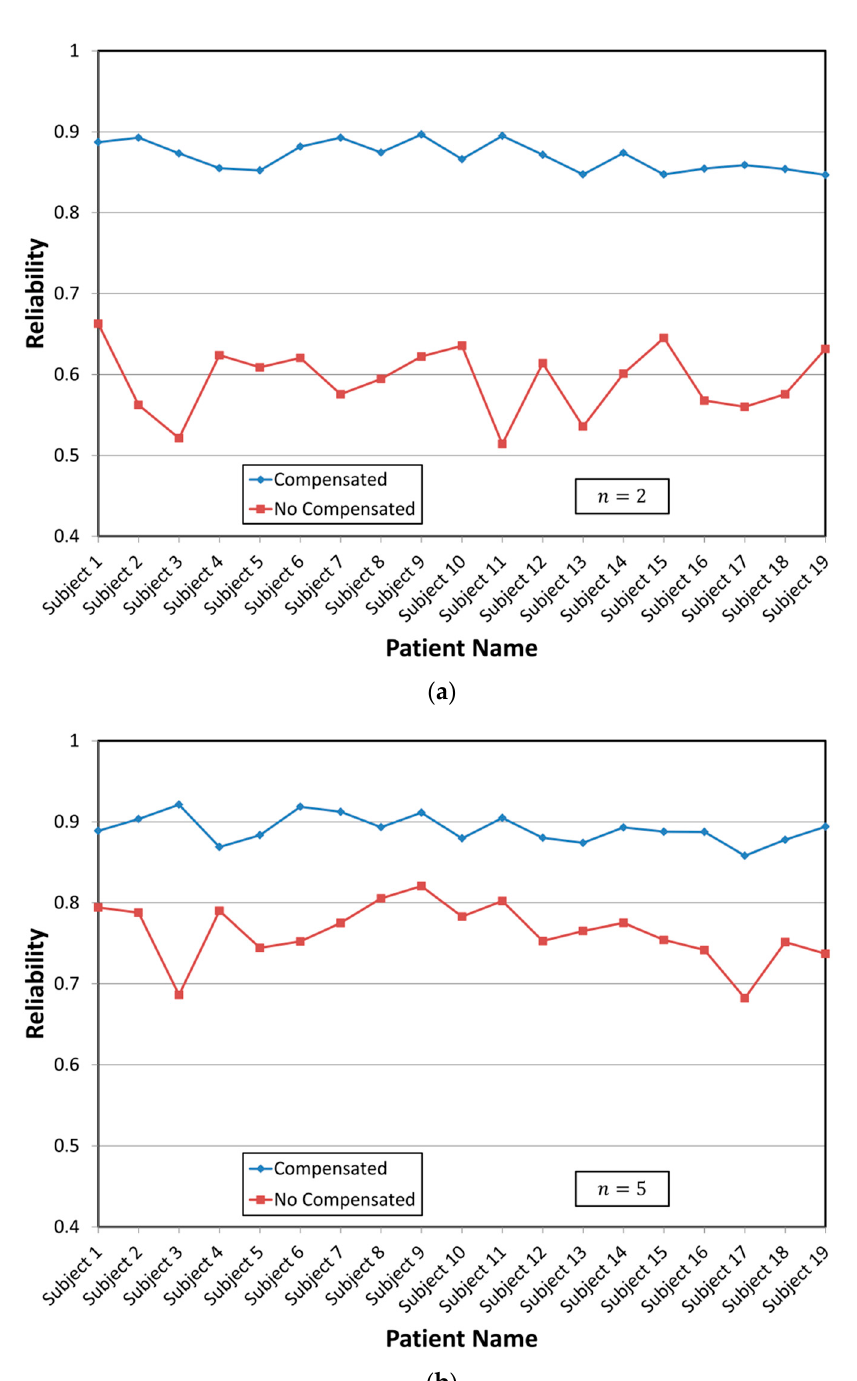
Figure 10. Corrected and uncorrected reliability (R) calculations; ( a ) with two clinical studies; ( b ) with five clinical studies.